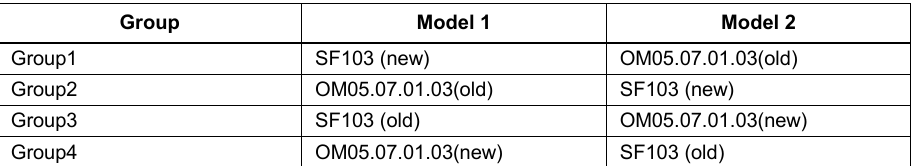
Table 4. Latin Square experimental